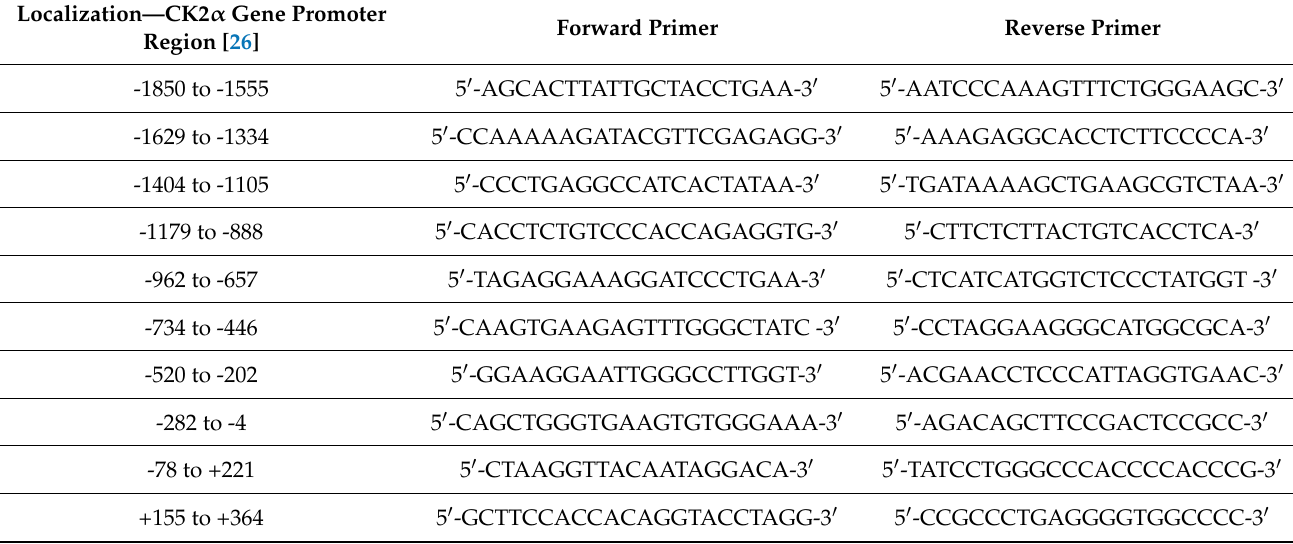
Table 1. Primers used for CK2 α promoter